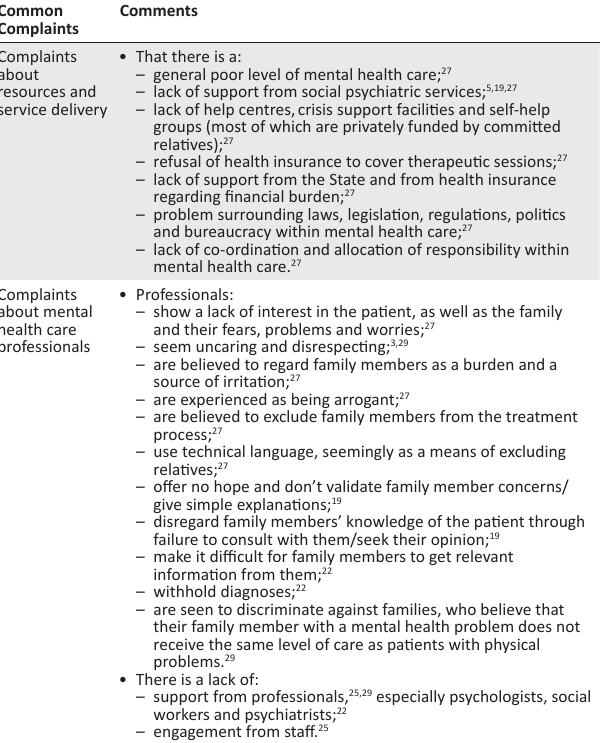
TABLE 3: Common complaints by families and caregivers about resources, service delivery and mental health care professionals. Common